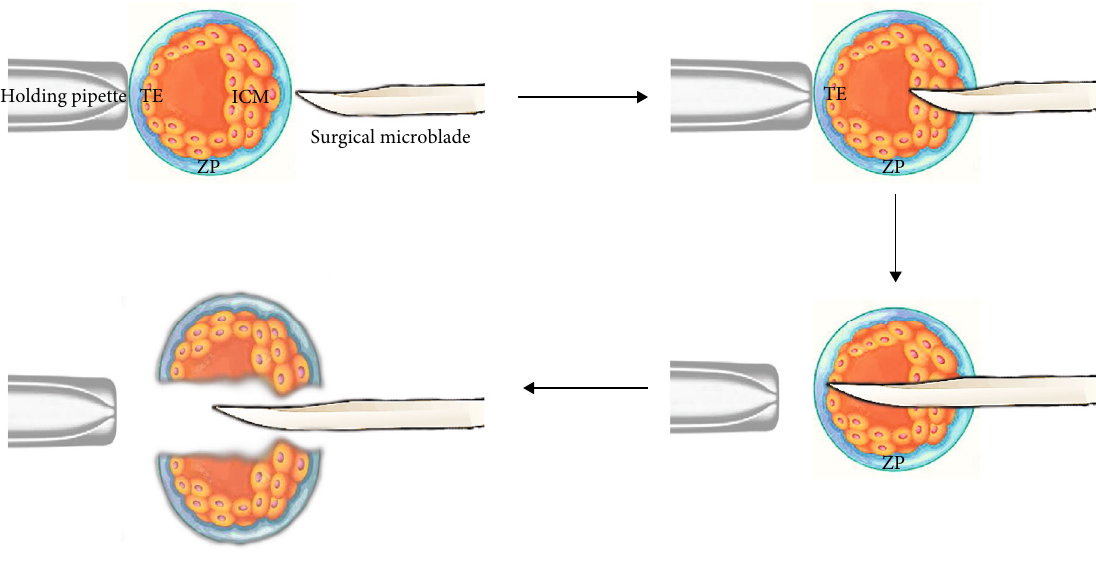
Figure 6: Blastocyst bisection Table 1: Comparing blastomere biopsy and bisection.